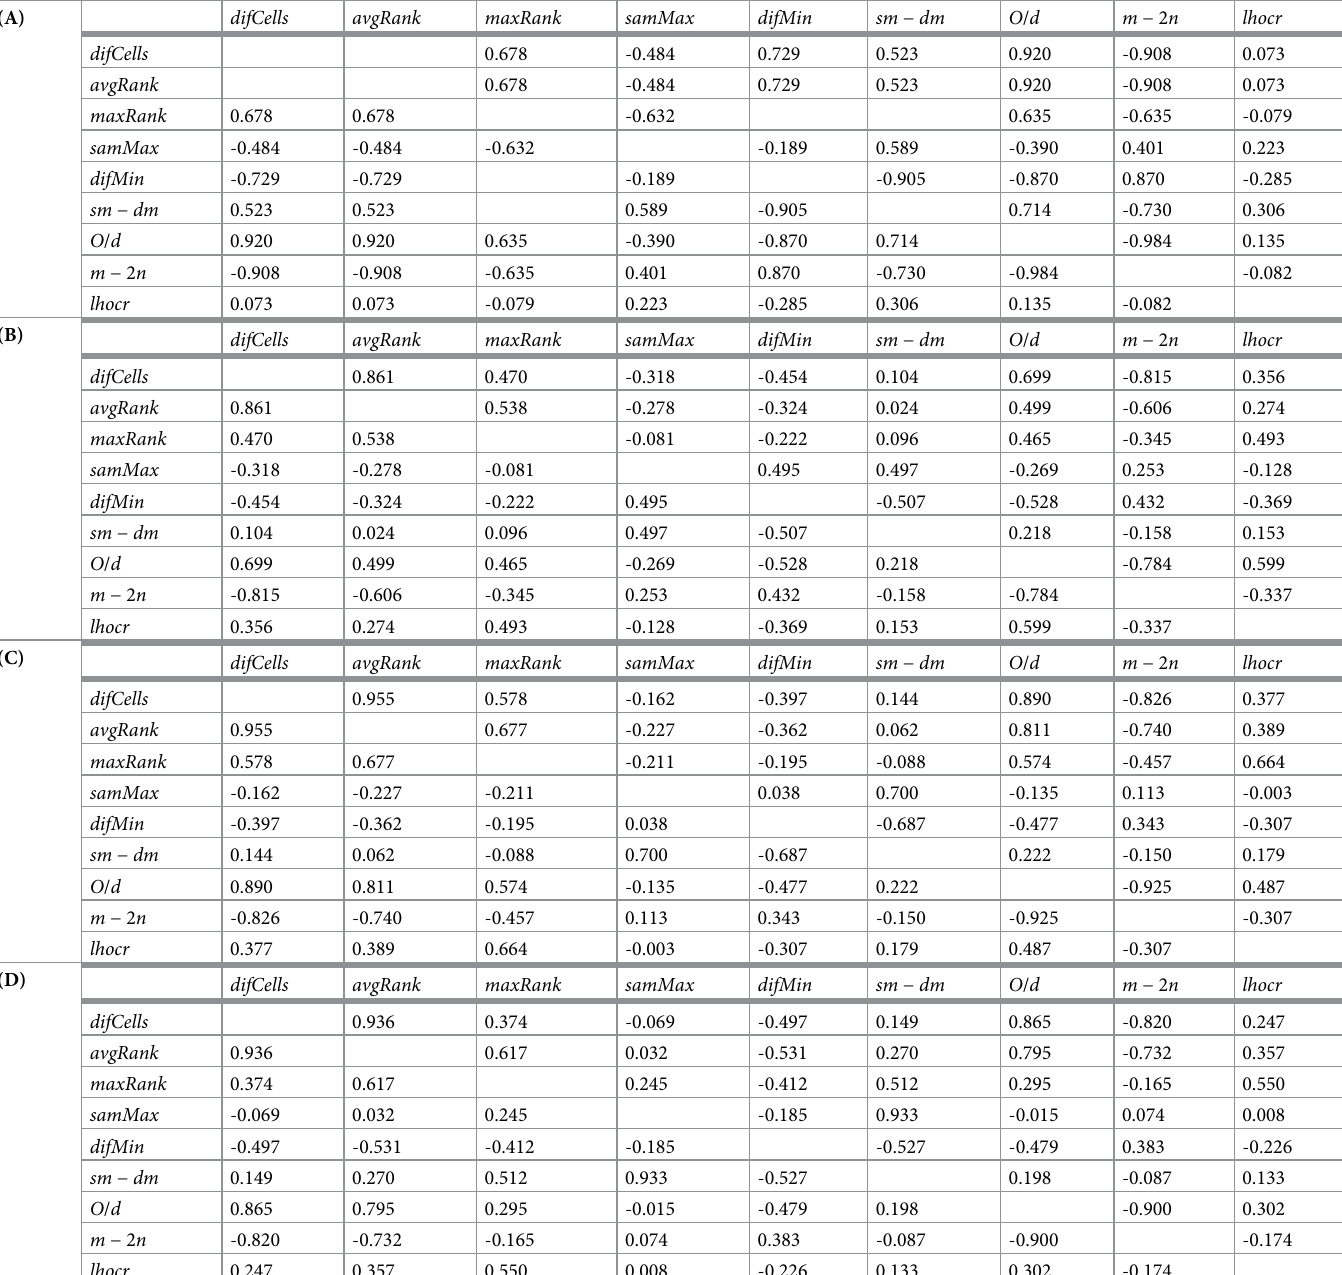
Table 3. Correlation coefficient for each pair of two